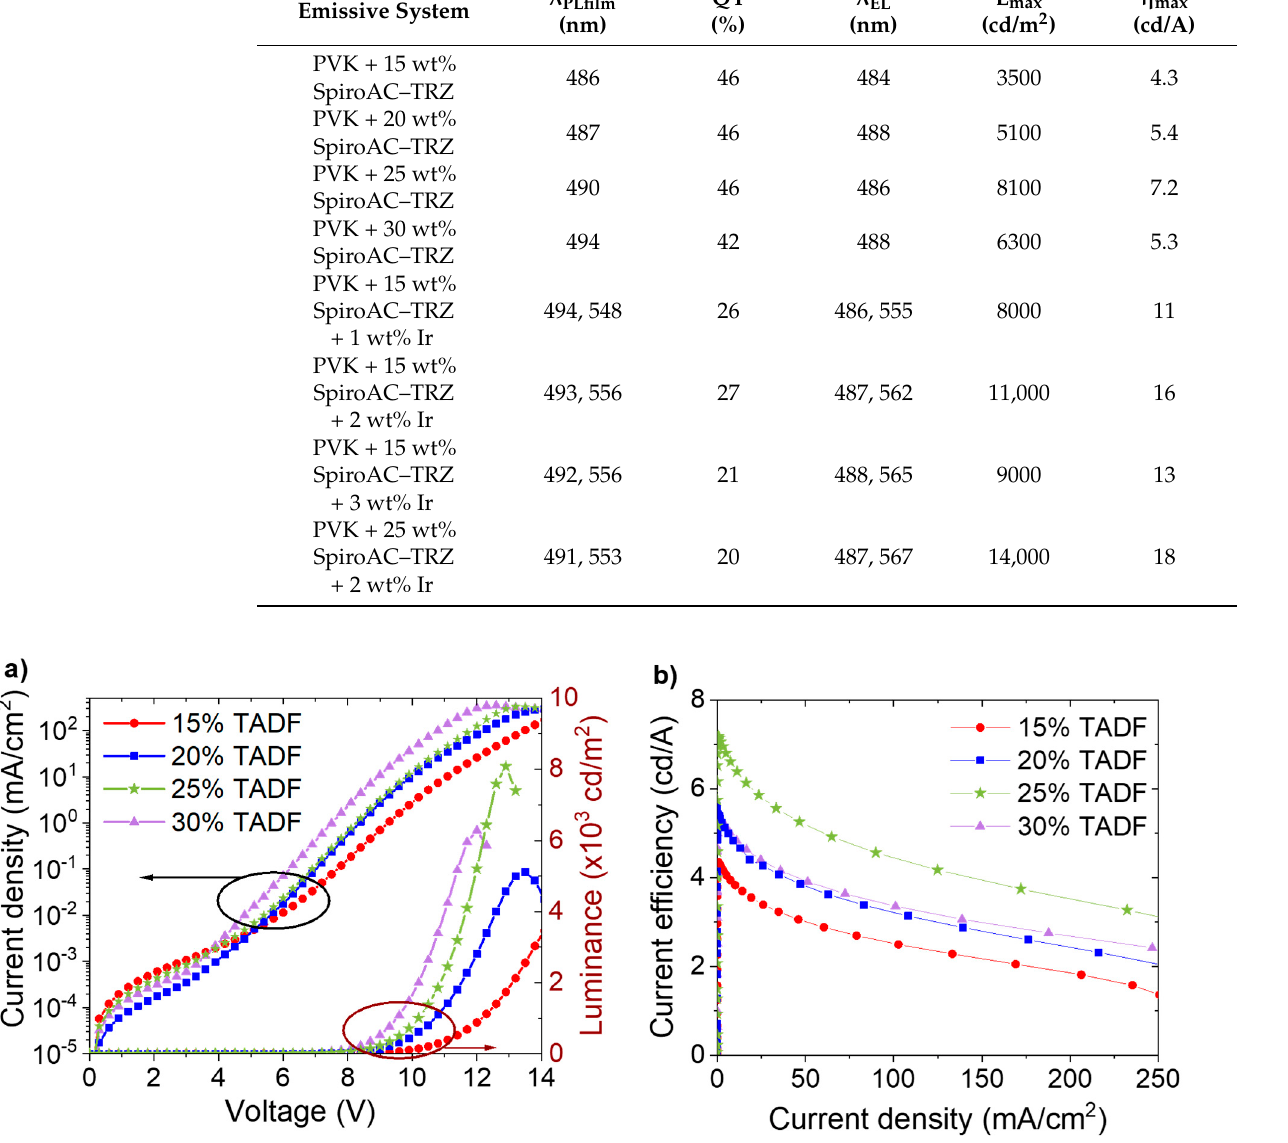
Figure 3. Working parameters of OLEDs based on PVK doped with different SpiroAC–TRZ (TADF) concentration: ( a ) J – V – L characteristics: current density–voltage characteristics (left) and luminance–voltage characteristics (right); ( b ) Current efficiency vs current density. OLED configuration: ITO/PEDOT:PSS (20 nm)/light emitting layer (LEL) (70 nm)/TPBi (20 nm)/Liq (2 nm)/Ag (100 nm). Table 1. Photophysical parameters of emissive layers of PVK with different SpiroAC–TRZ (thermally activated delayed fluorescence (TADF) assistant dopant) and Ir concentrations as well as organic light emitting diodes (OLED) parameters based on such systems. OLED configuration: ITO/PEDOT:PSS (20 nm)/light emitting layer (LEL) (70 nm)/TPBi (20 nm)/Liq (2 nm)/Ag (100 nm).